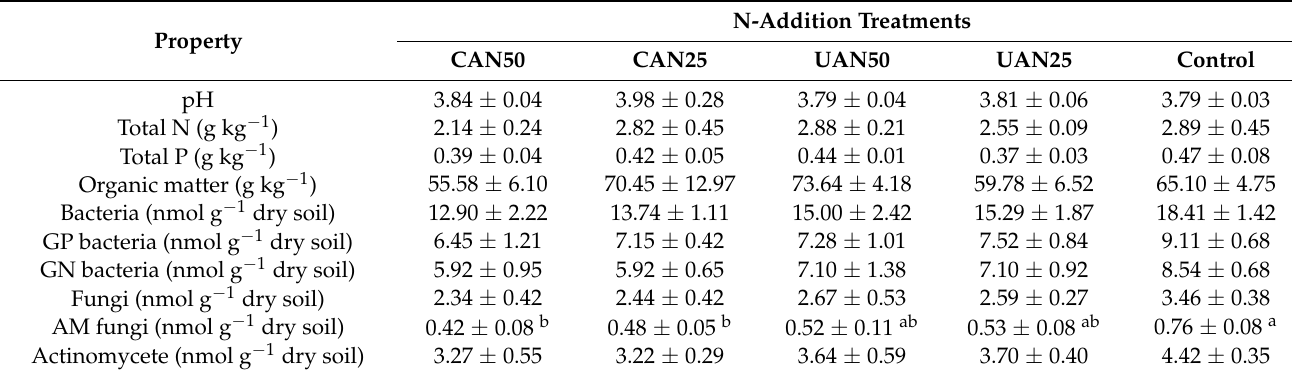
Values are means ± standard error of mean (SEM). Means in a row followed by different letters (a,b) are significantly different ( p < 0.05). GP bacteria: Gram-positive bacteria; GN bacteria: Gram-negative bacteria; AM fungi: arbuscular mycorrhizal fungi. Treatments are described in Table 1 and in the